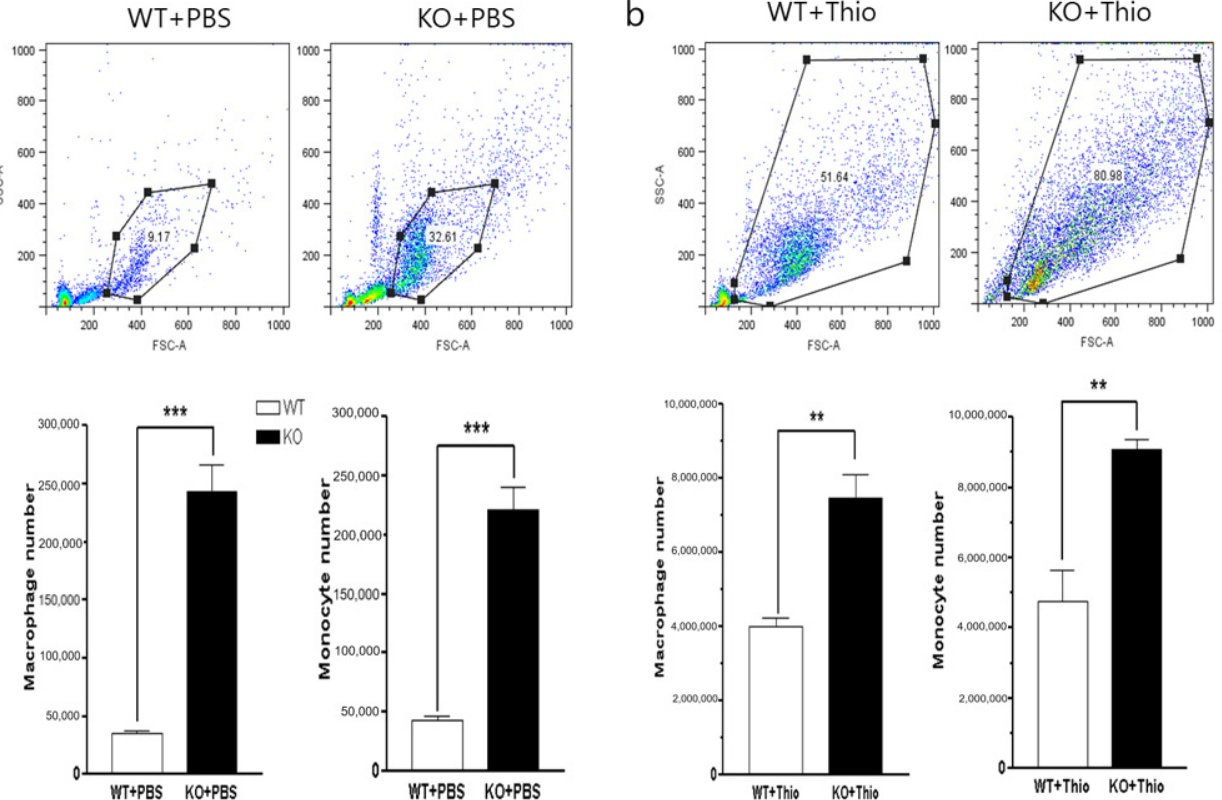
Figure 4. Endothelial CAR deletion increases inflammatory cell infiltration into the peritoneal cavity. ( a , b ). Ten-week-old male WT and KO mice were treated with PBS or 3% thioglycolate for 7 days, and peritoneal cells were isolated, stained with the indicated antibodies (monocytes = Gr-1 and macrophages = CD11b) and subjected to fluorescence-activated cell sorting (FACS) analysis. All data are the mean ± s.e.m. from 3 independent experiments. ** p < 0.01 and *** p < 0.001 by two-tailed Student’s t -test.